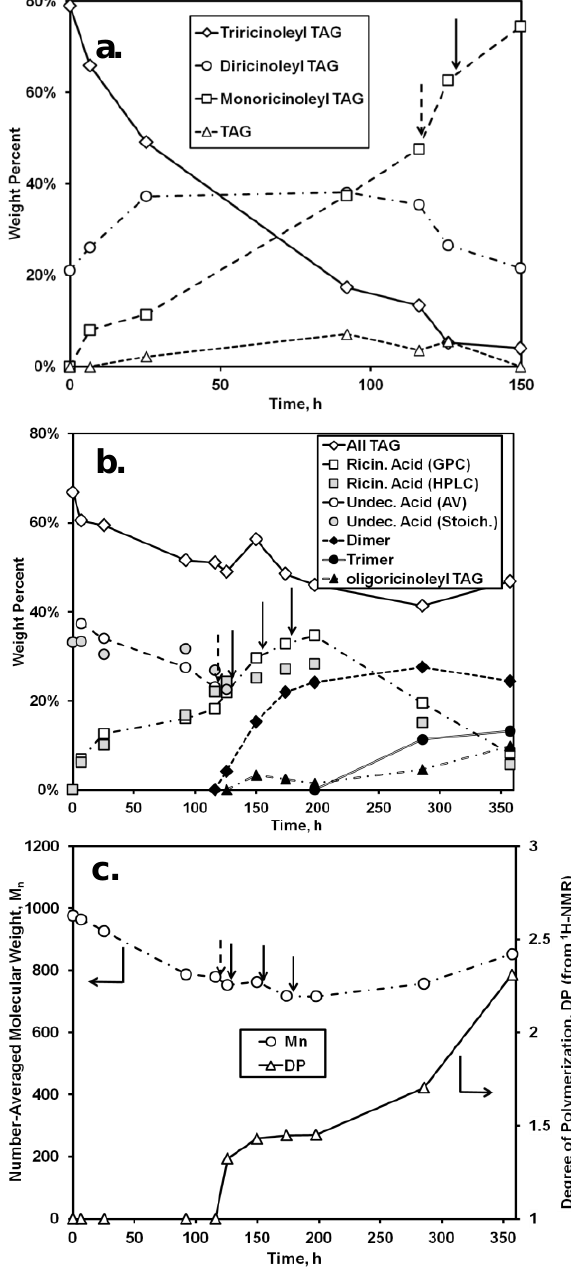
Figure 5. Time course of reaction for the lipase-catalyzed synthesis of TAG containing oligo -ricinoleic acid and 10-undecenoic acid. ( a ) change in distribution of TAG species (determined from normal phase HPLC analysis; “TAG” refers to TAG not containing ricinoleic acyl groups); ( b ) change in concentration of TAG, fatty acid, and oligomer (determined from normal phase HPLC, unless noted otherwise; “AV” and “Stoich” refer to the wt % of 10-undecenoic acid determined from acid value measurements and from stoichiometry: equating the amount of released ricinoleic acid to the amount of undecenoic acid consumed, respectively); ( c ) change of number-averaged molecular weight and degree of polymerization for fatty acids (determined from, GPC and 1 H-NMR, respectively). Dashed arrow refers to the replacement of RML with CAL; solid arrows refer to the addition of (9.5 g, 32 mmol) of ricinoleic acid. Reaction conditions are given in Figure 4.